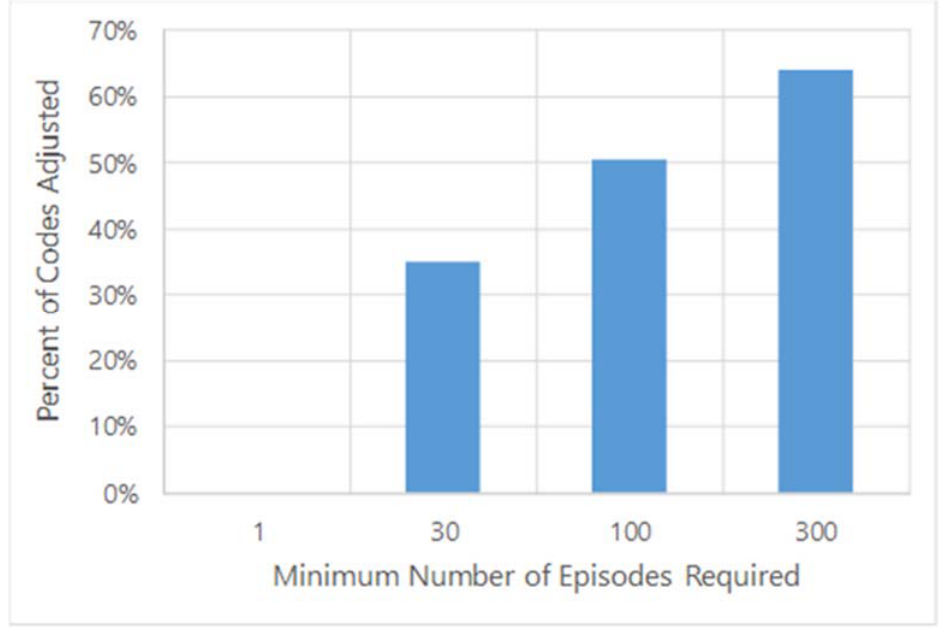
Figure 2. Percentage of codes adjusted for different thresholds.